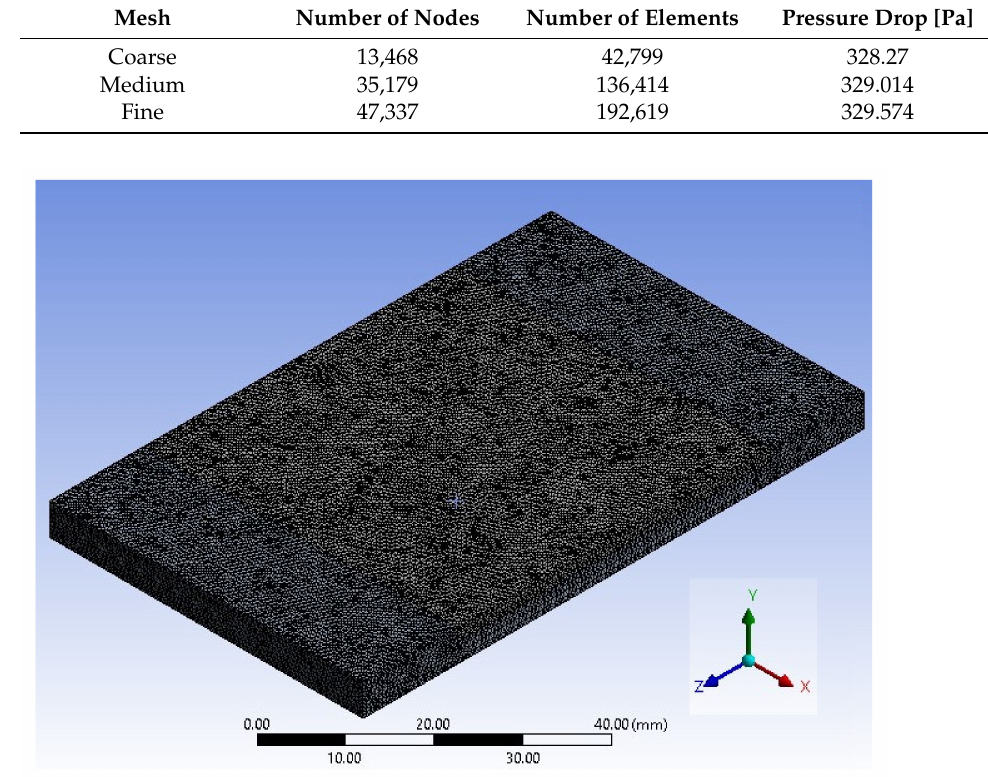
Figure 6. Complete meshed geometry using medium